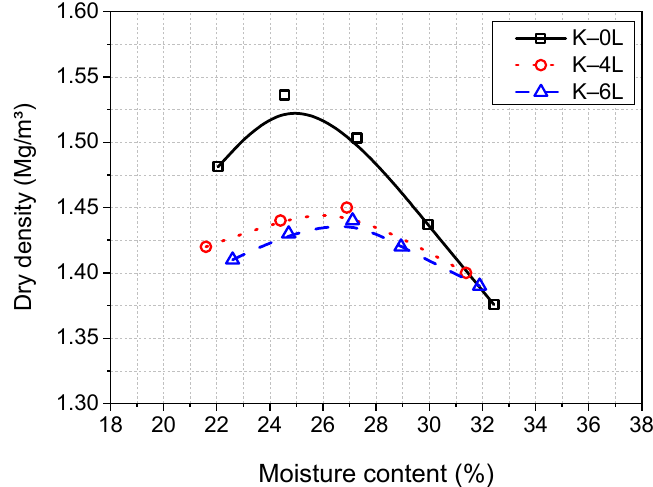
Figure 3. Proctor compaction curves of kaolin specimens stabilised with three different levels of lime (mainly 0, 4, and 6 wt%).